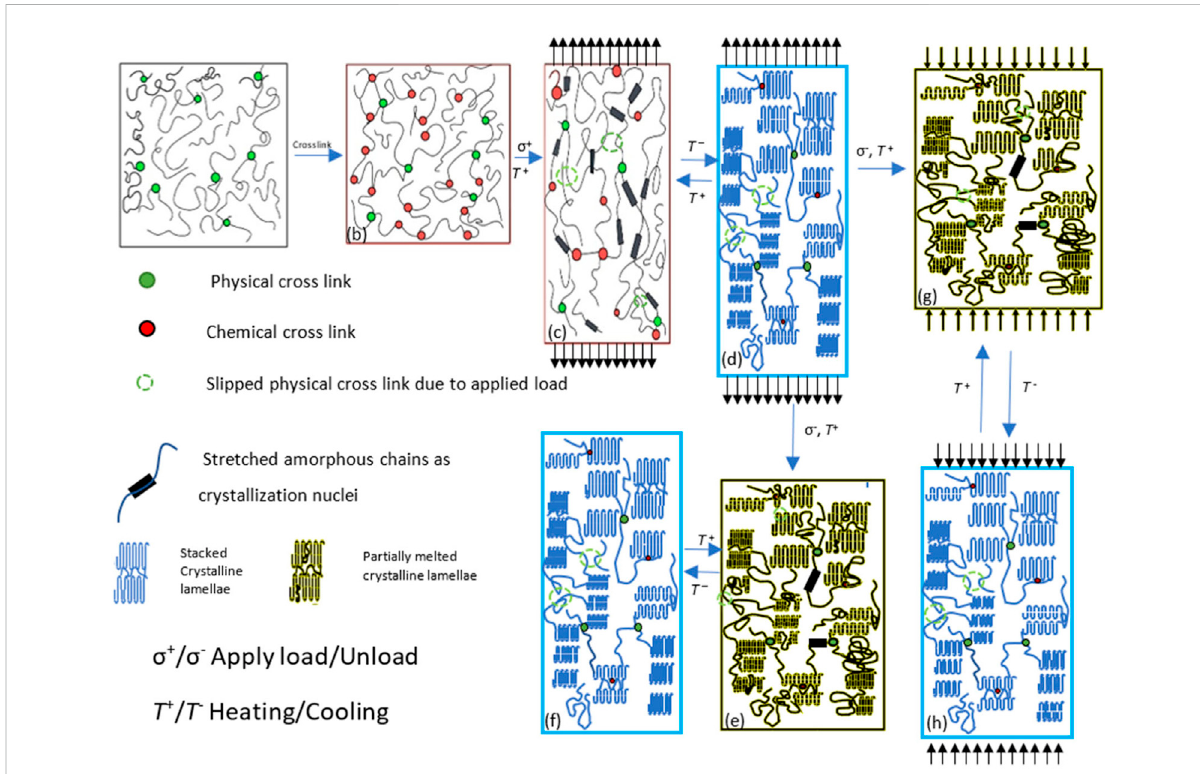
FIGURE 11 Schematic of how the chemically crosslinked two-way shape memory polymer works at a molecular level [redrawn from Figure 1 in ref (Yan et al., 2020b); T : temperature; σ : stress] [Reproduced with permission from Int. J. Mech. Sci., 177 (2020). Copyright 2020 from